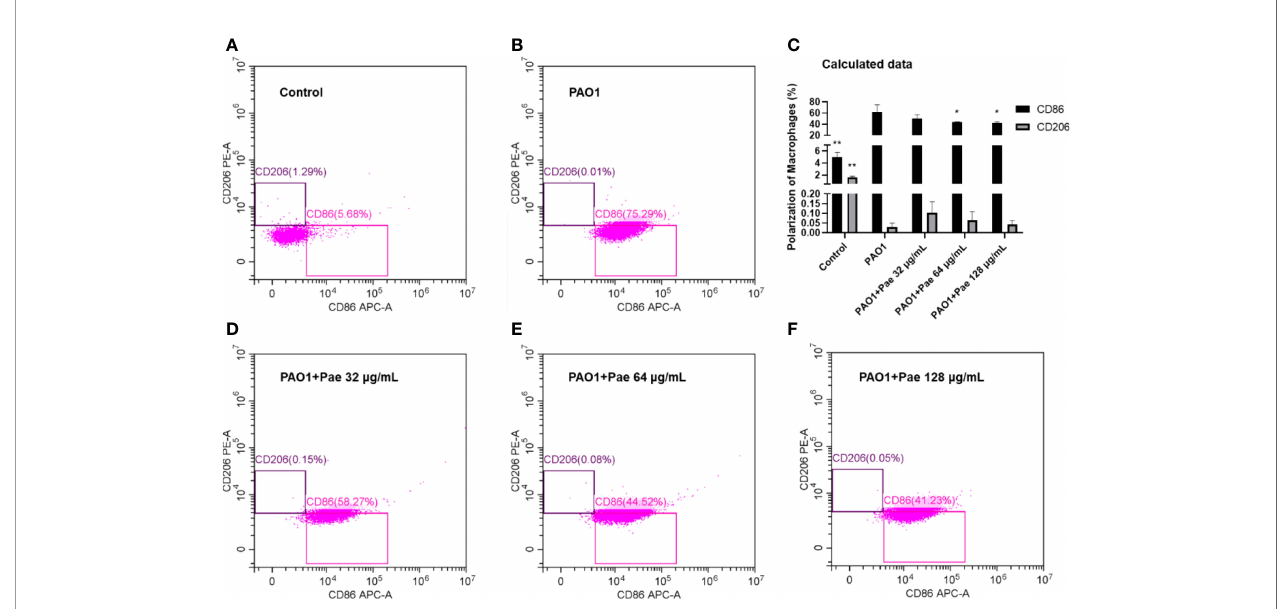
FIGURE 9 | Paeonol changed the Polarization of Macrophages infected with PAO1 (MOI = 25:1). Control (A) , PAO1 (B) The data in “ PAO1+Pae 32 m g/mL ” (D) , “ PAO1+Pae 64 m g/mL ” (E) , and “ PAO1+Pae 128 m g/mL ” (F) indicated that Paeonol reversed the upregulated the biomarker of CD86 of RAW264.7 cells infected with PAO1 (C) . The cell polarization was distinguished by Flow cytometry. All data were expressed as means ± SD (n=3). * P < 0.05 or ** P < 0.01 vs PAO1